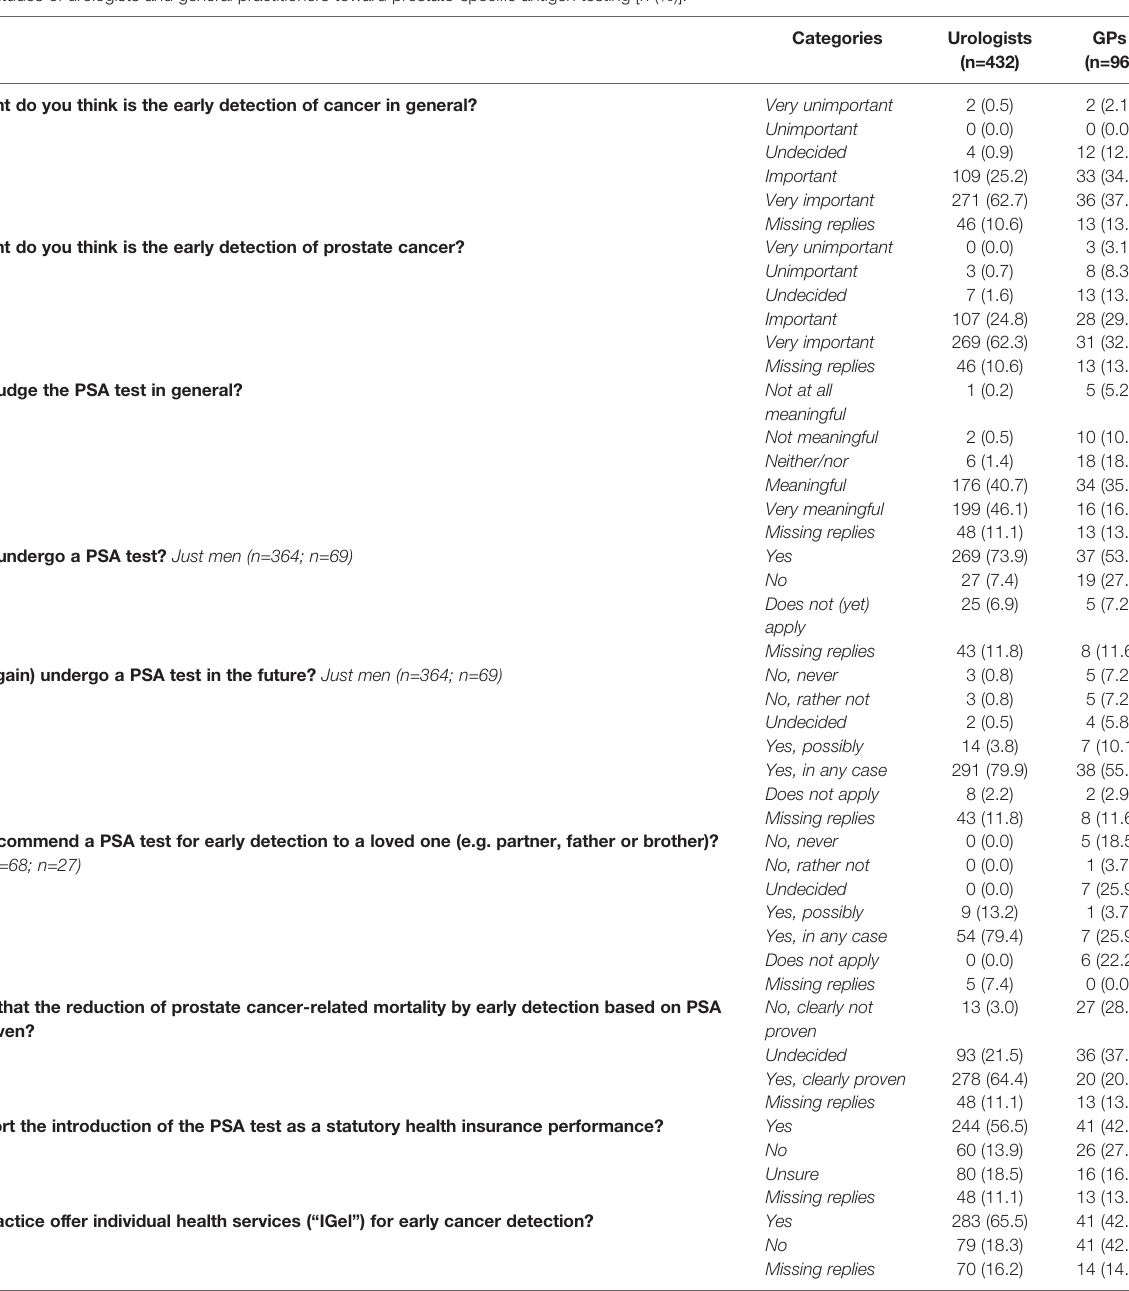
TABLE 3 | Attitudes of urologists and general practitioners toward prostate-speci fi c antigen testing [n